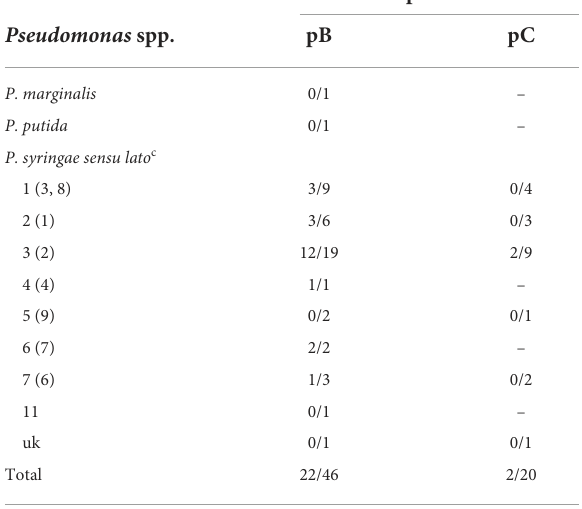
TABLE 2 Conjugative transfer of plasmids pB and pC from P. syringae pv. savastanoi NCPPB 3335 to different strains and species of Pseudomonas a